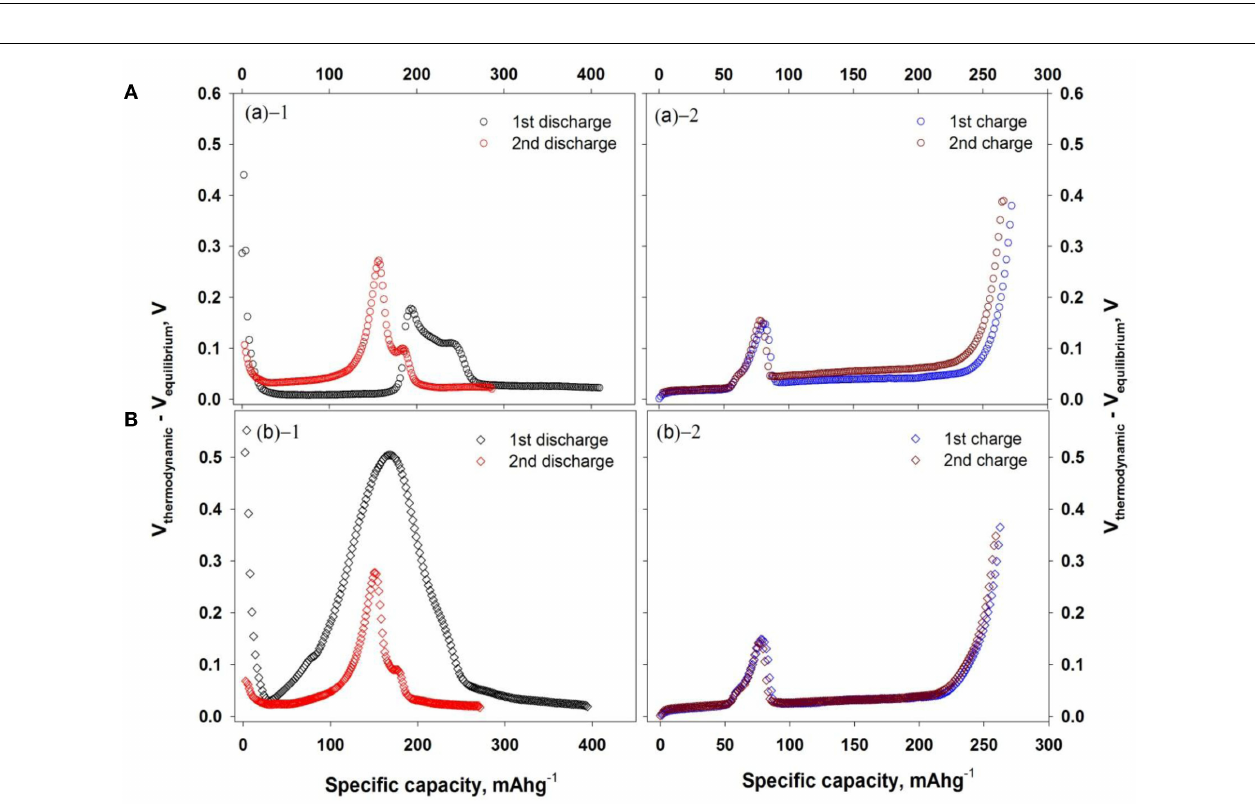
FIGURE 9 | Thermodynamic and equilibrium potential differences of LTO- and Al 2 O 3 -coated LTO at first two charge–discharge cycles from galvanostatic intermittent titration technique (GITT): (A) LTO electrode and (B) Al 2 O 3 -coated LTO electrode .